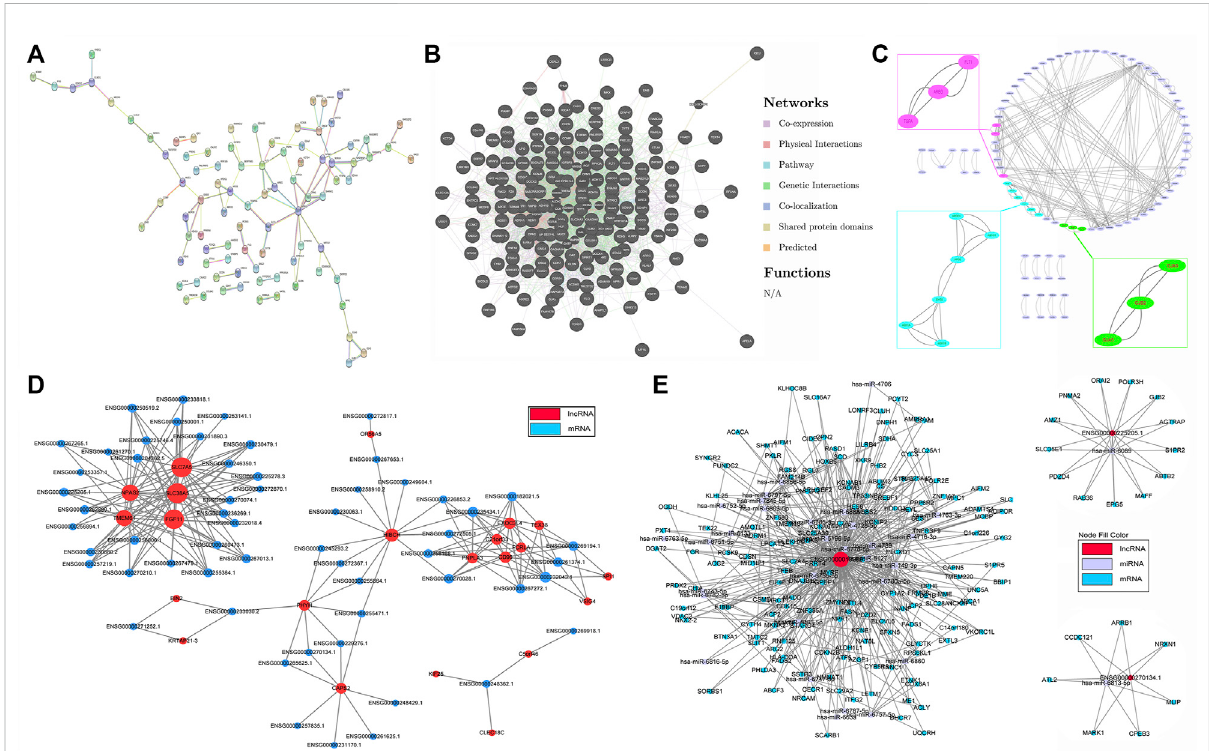
FIGURE 5 Interactionandco-expressionnetworkanalysis. (A) Protein – proteininteraction(PPI)networkbasedonDEmRNAs. (B) Thespeci fi cinteractions between DE genes in the PPI network. (C) The signi fi cant hub nodes and molecular complex clustered by the MCODE in the PPI network. (D) Co- expression network of DE lncRNAs and DE mRNAs. (E) ceRNA network of DE lncRNAs, mRNAs and their predicted miRNAs.